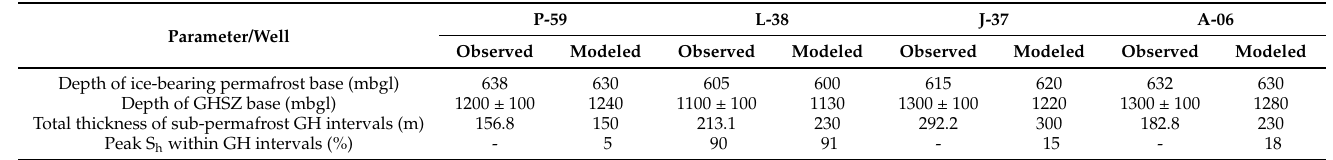
Table 4. Comparison of the well-log-inferred data with the simulated key parameters of the GHSZ and permafrost distributions as well as GH saturation